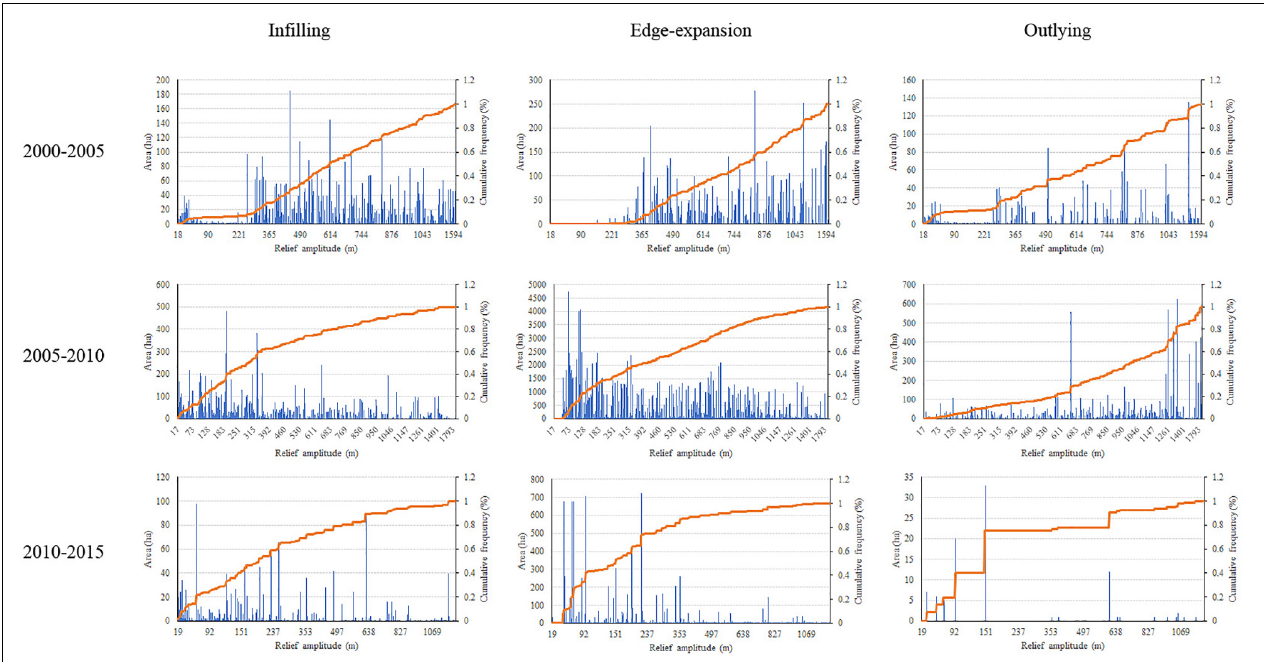
FIGURE 6 | Topographic relief effect in cropland expansion trajectories in C&YUA from 2000 to